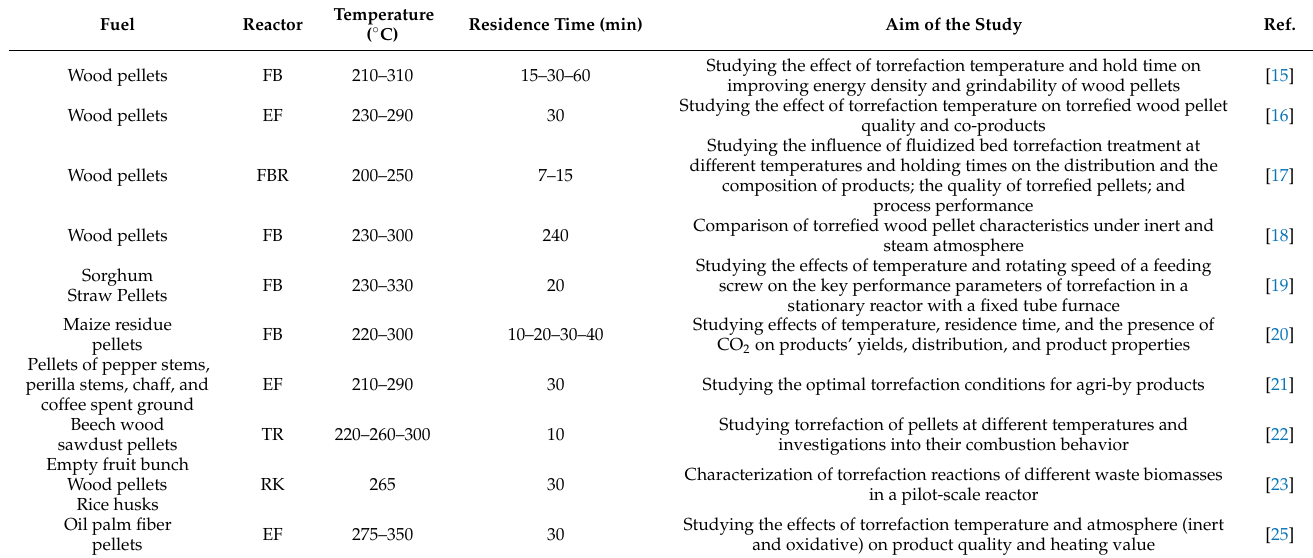
Table 1. Summary of lab-scale studies in the literature on downstream torrefaction of biomass pellets (FB: fixed-bed, EF: electrical furnace, FBR: fluidized bed reactor, TR: tube reactor, RK: rotary kiln).